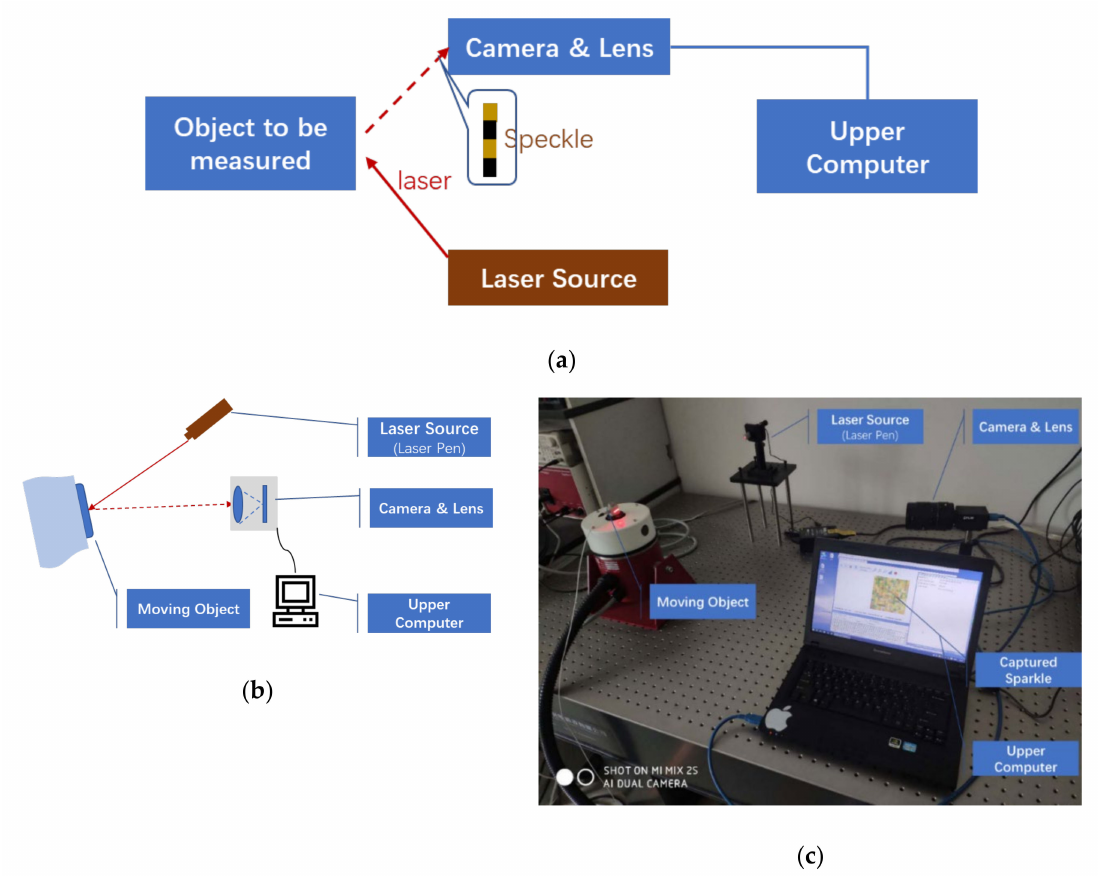
Figure 5. Hardware system and experiment scenarios of Viaxl: ( a ) Block diagram of Viaxl system; ( b ) system diagram of Viaxl hardware prototype; ( c ) experiment